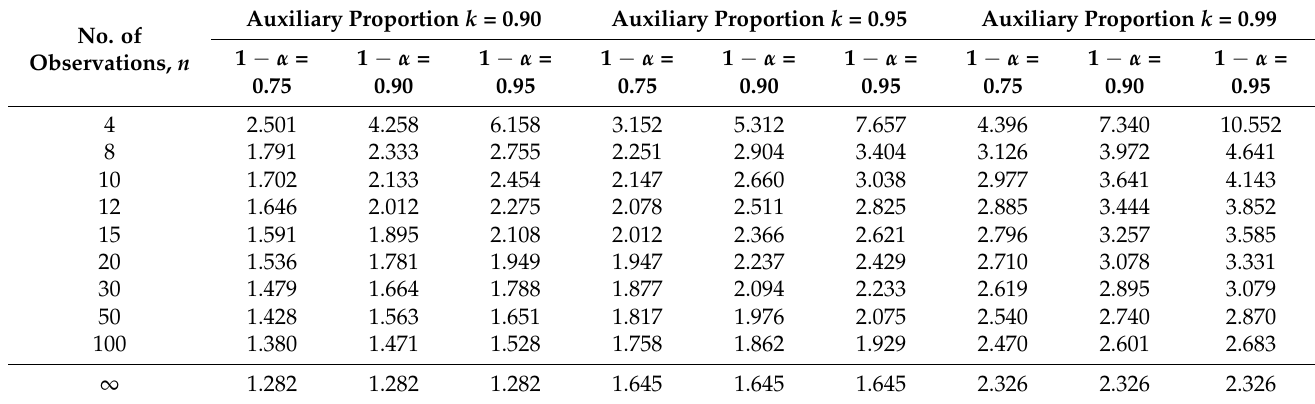
Table 4. Quantiles c 1 − α , k ( n − 1 ) for various auxiliary proportions k and confidence levels 1 − α